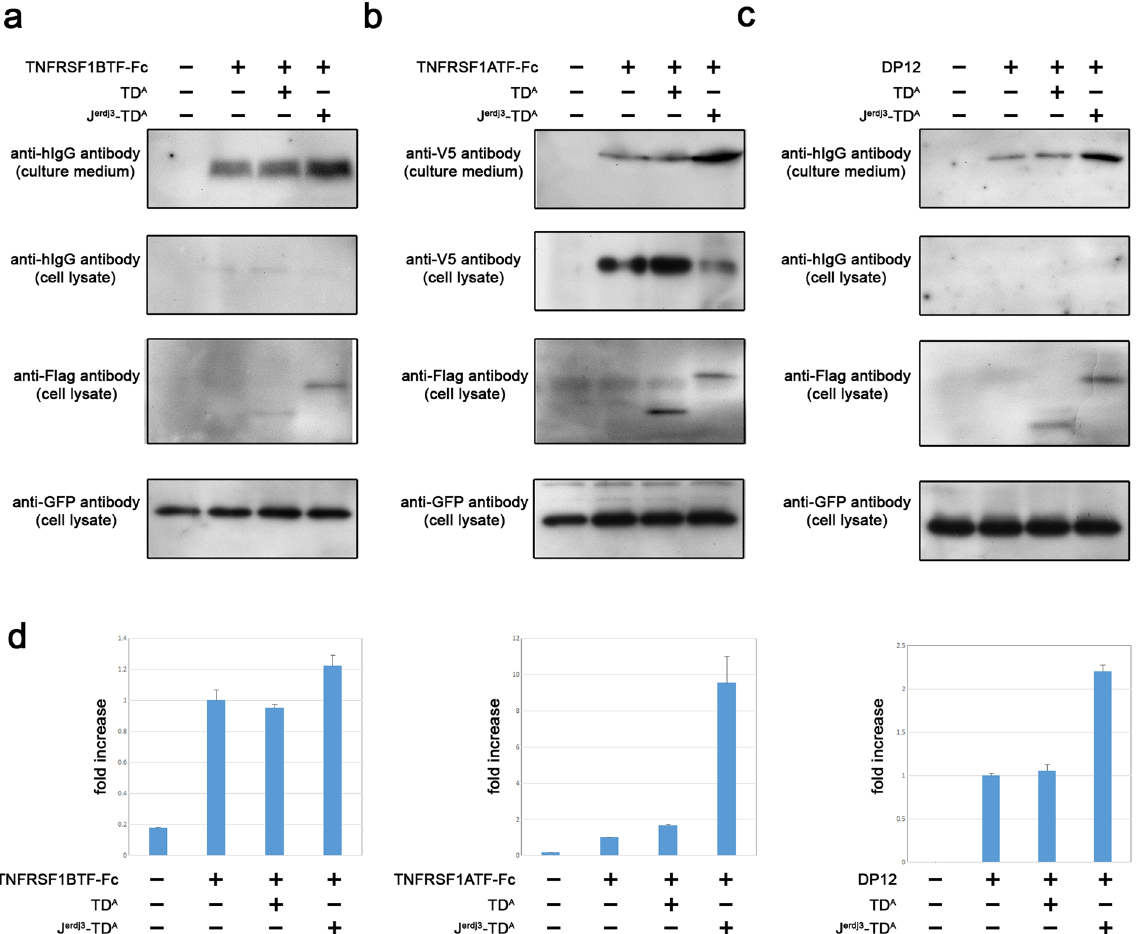
Figure 3. Enhanced secretion of Fc-fusion proteins and monoclonal antibodies. ( a ) Fc-fusion protein with the extracellular domain of Tumor necrosis factor receptor superfamily member 1B (TNFRSF1BTF-Fc) was expressed in HEK293 cells with ( + ) or without ( − ) a Flag-tagged protein A (TD A ) or a Flag-tagged J-domain fragment fusion protein carrying protein A as a targeting domain (J erdj3 -TD A ). Two days later, the cell culture medium was harvested, and a western blot assay was performed with anti-human IgG antibody to detect TNFRSF1BTF-Fc. J erdj3 -TD A in cell lysate was detected by an anti-Flag antibody. GFP was expressed in all samples as a transfection reporter. ( b ) The same J-domain fragment fusion protein (J erdj3 -TD A ) was expressed with Fc-fusion protein of the V5-tagged Tumor necrosis factor receptor superfamily member 1 A (TNFRSF1A-V5-Fc) in HEK293 cells. TNFRSF1A-V5-Fc and J-domain fusion protein were detected in the cell culture medium and cell lysate, harvested two days after transfection, by western blot analysis using an anti-V5 antibody or anti-Flag antibody, respectively. A reporter plasmid (GFP) was co-transfected to monitor transfection efficiency (lower panel). ( c ) The dual-expression plasmid expressing both heavy chain and light chain for anti-IL8 antibody was transfected in HEK293 cells with ( + ) or without ( − ) a J-domain fragment fusion protein carrying protein A as a targeting domain (J erdj3 -TD A ). Two days later, the cell culture medium was harvested, and antibody production was detected by western blot analysis using an anti-human IgG antibody. The J-domain fragment fusion protein and reporter protein (GFP) was detected in the cell lysate by an anti-Flag antibody and anti-GFP antibody, respectively. ( d ) The culture media from cells expressing Fc fusion proteins or antibodies were harvested, and their antigen-binding activities were measured by ELISA. Fc fusion proteins and antibody were expressed with (forth bar) or without (second bar) targeting the J-domain fragment fusion proteins (J erdj3 -TD A ). As a control, target proteins were expressed with targeting domain only (TD A ; third bar). The culture medium from control transfectant (empty vector transfection control) was shown in the left bar. Assay plates were coated with the corresponding antigens or binding ligands, and the secreted Fc fusion proteins or antibodies were applied to the respective plates. Bound antibodies or Fc fusion proteins were detected with HRP-conjugated anti-hIgG